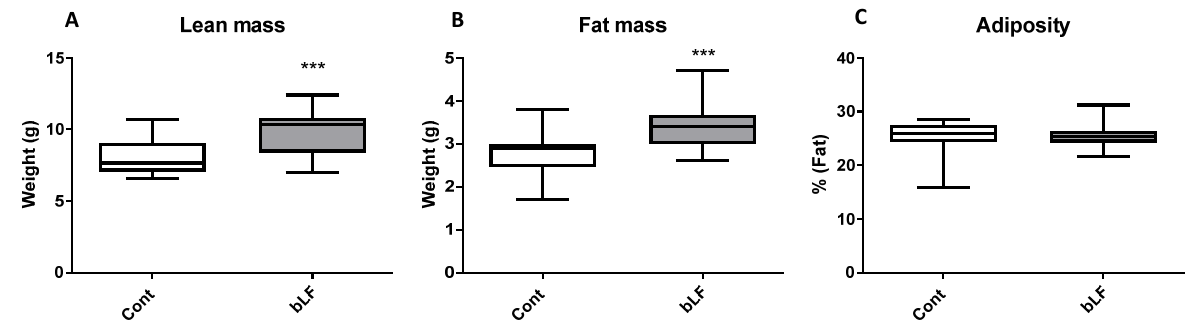
Figure 2. Composition of body weight at postnatal day 17 (DEXA values) of pups with maternal bLF supplementation (bLF) or without supplementation (Cont). ( A ) Effect of maternal bLF supplementation on the lean mass. ( B ) Effect of maternal bLF supplementation on fat mass. ( C ) Effect of maternal bLF supplementation on adiposity. Data represented are means ± SEM (*** p < 0.001; n = 16 per group). The control and lactoferrin groups were compared by an unpaired two-tailed Student’s t -test. Table 2. Body composition of the pups recovered from mothers receiving the control diet or the bLF-supplemented diet. The body composition was determined at postnatal day 17.